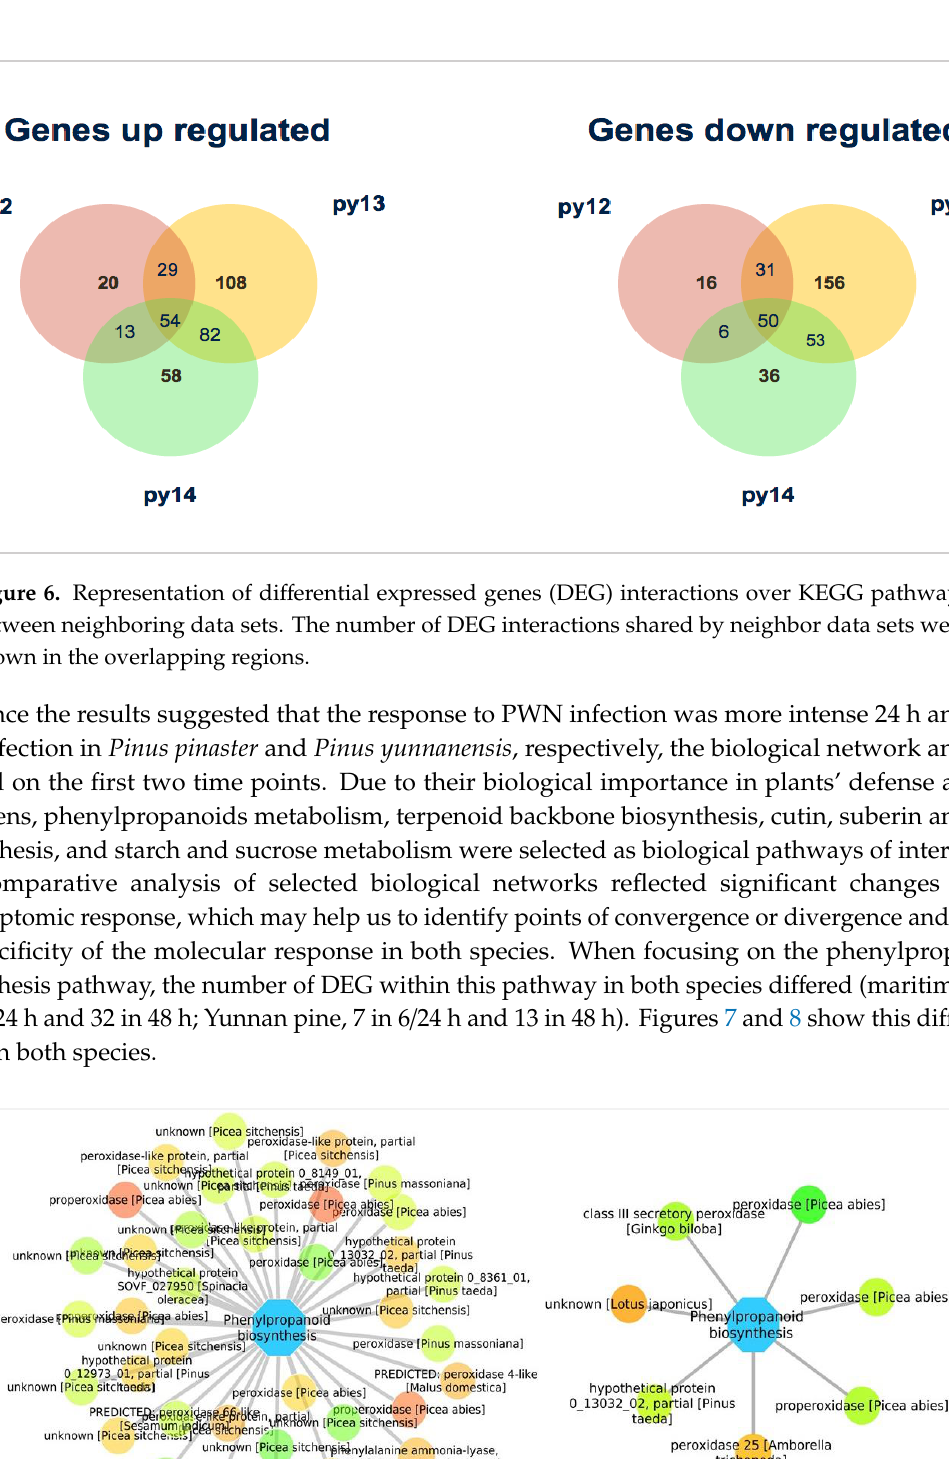
B A Figure 7. Phenylpropanoid biosynthesis pathway with interactions assigned to DEG in Pinus pinaster ( A ) and in Pinus yunnanensis ( B ) at the first time point after inoculation (6 + 24 h). The blue node represents the pathway. The circular nodes represent DEG assigned to the pathway. Note that due to the complexity of representing the expression values of those genes in all the stages, the expression was colored on an RGB scale that goes from the most down-regulated in red to the most up-regulated in green.